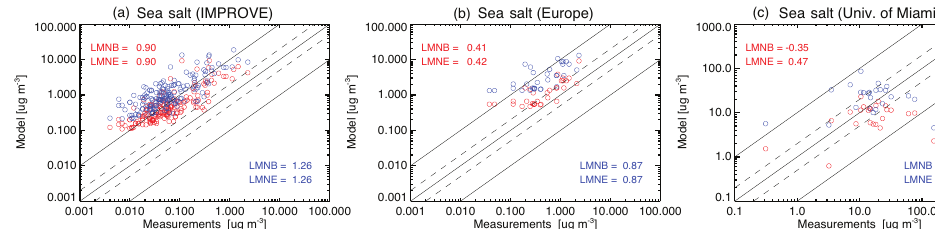
Figure 10. Same as Fig. 8 but for sea-salt mass concentrations.